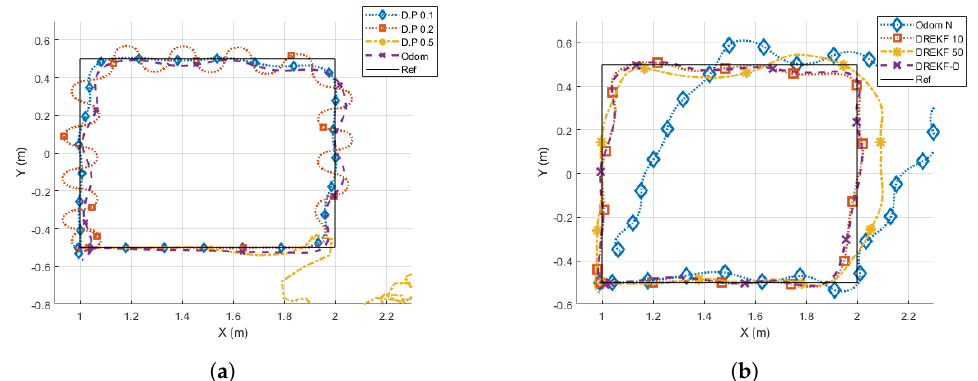
Figure 12. Results for a square reference. ( a ) D.P and Odom options. ( b ) Odom N and DREKF